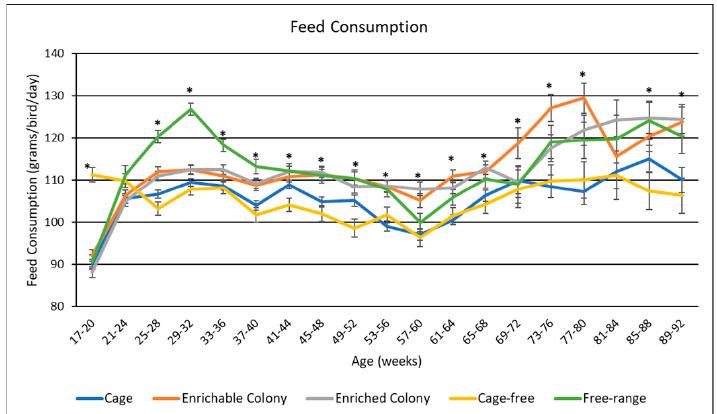
Figure 3. The effect of housing environment on feed consumption of brown egg layers by age. * Signifies a significant effect ( p < 0.05) of housing environment by age range on feed consumption.